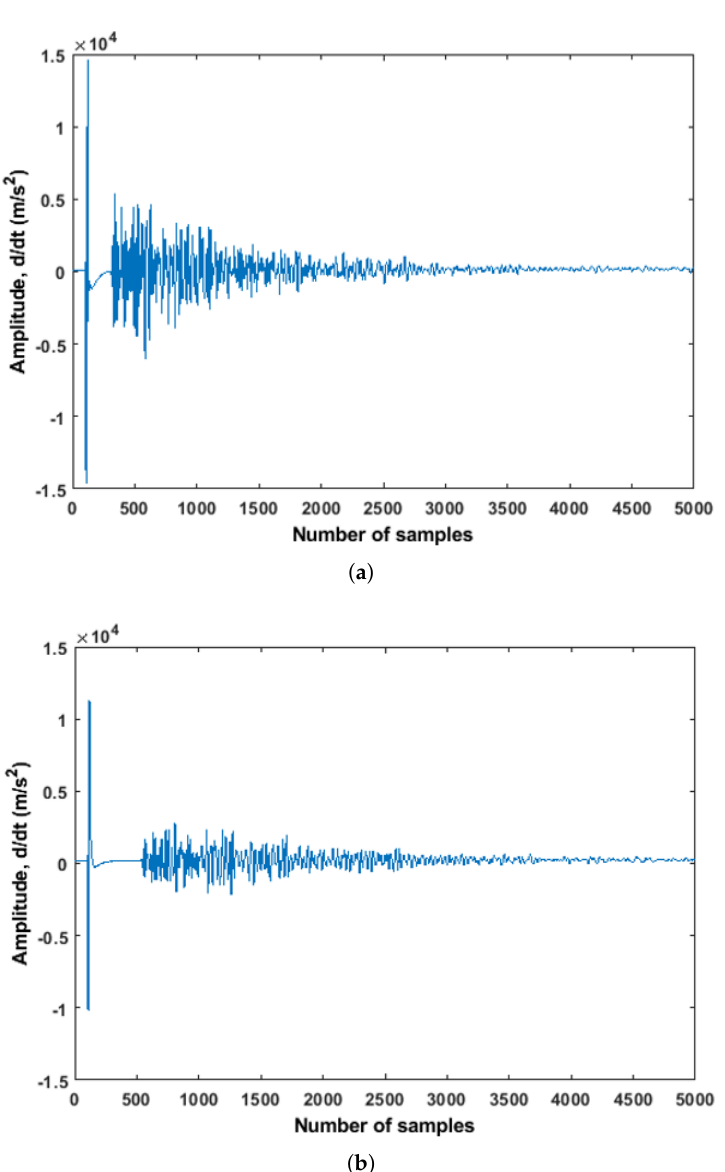
Figure 6. Raw signals from the top and bottom pair of sensors. ( a ) Raw signal acquired from the bottom pair of sensors (S02R03); ( b ) Raw signal acquired from the top pair of sensors